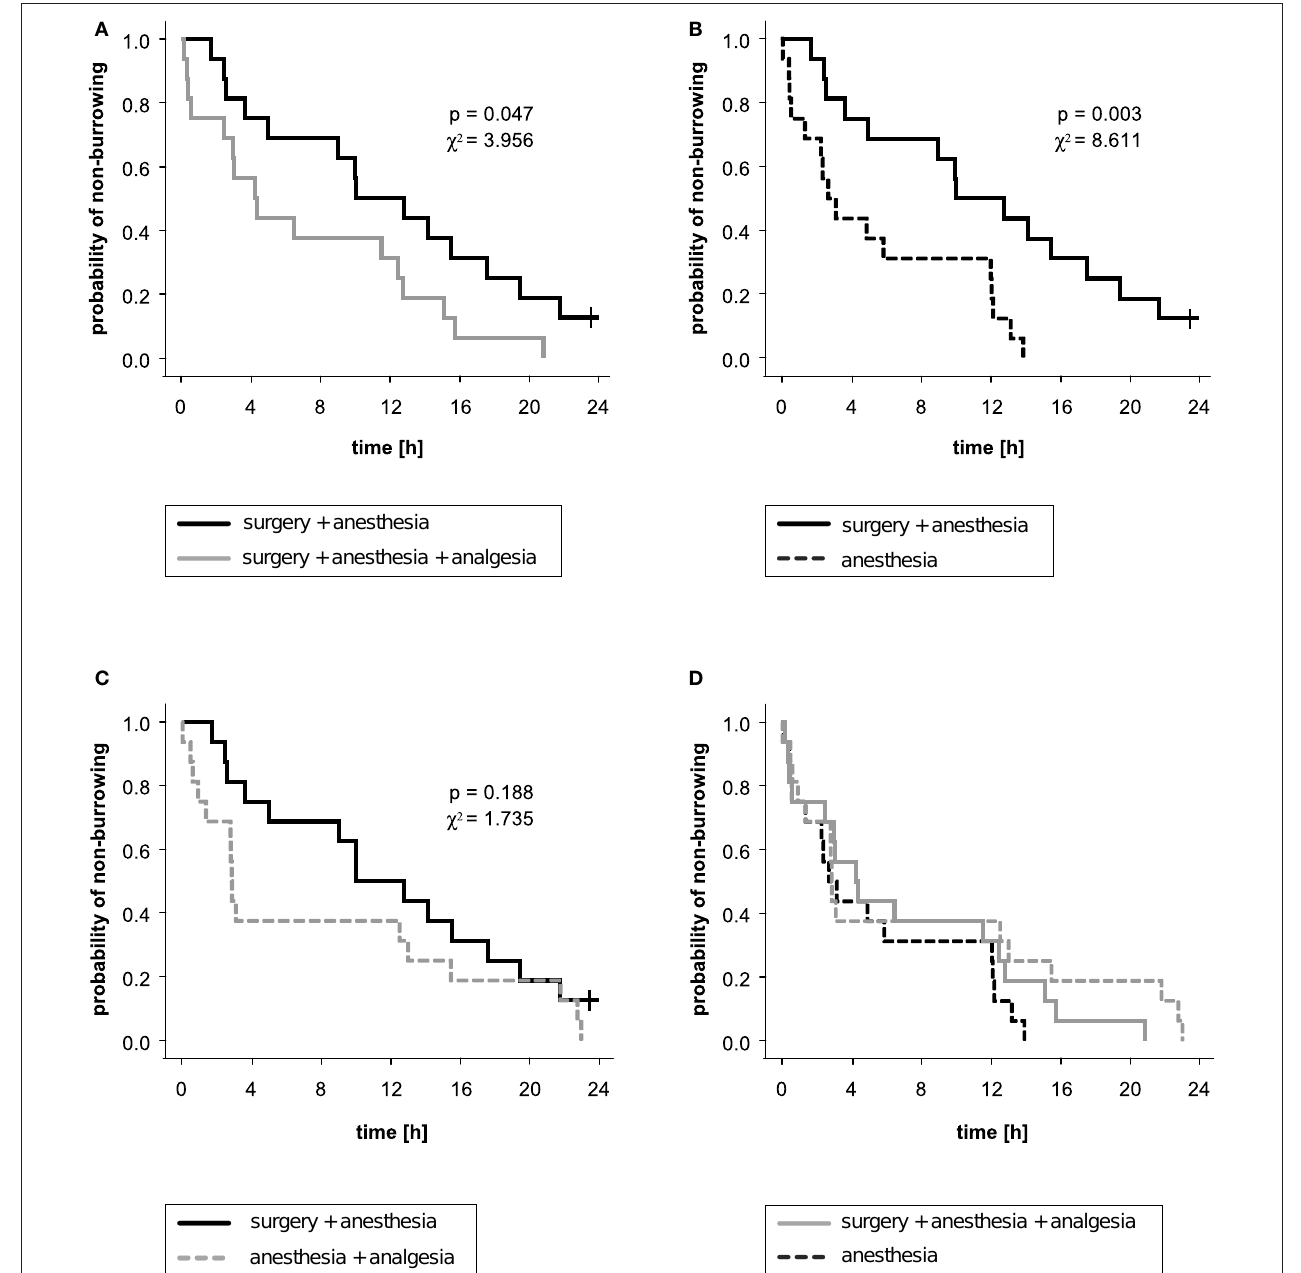
Figure 4 | Kaplan–Meier analysis and results of log rank significance test of latency to burrow. The curves indicate the probability that a mouse with a given treatment has not yet started to burrow. The probability of non-burrowing ( y -axis) is traced against the time to event in hours ( x -axis). (A) Significant difference between groups treated (or not) with an analgesic for surgery. (B) Significant difference between groups of mice that underwent anesthesia